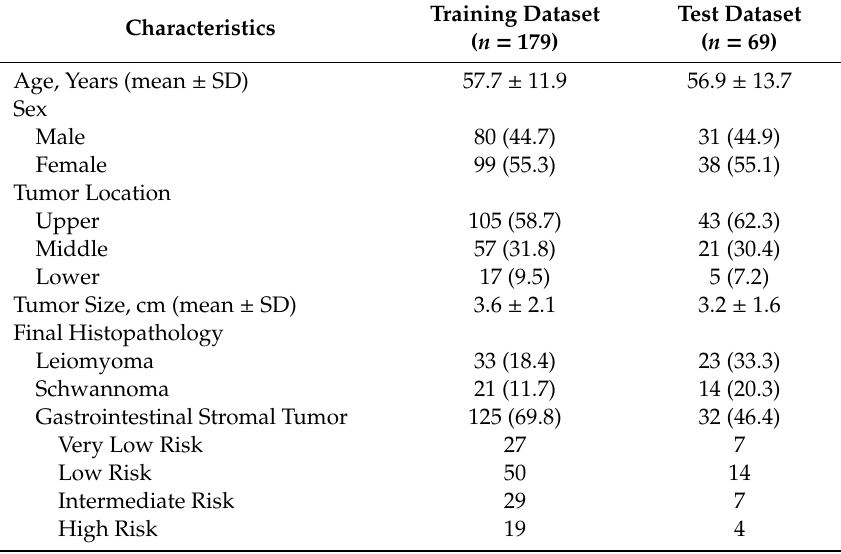
Table 1. Clinicopathological characteristics of patients with gastric mesenchymal tumors in the training and test